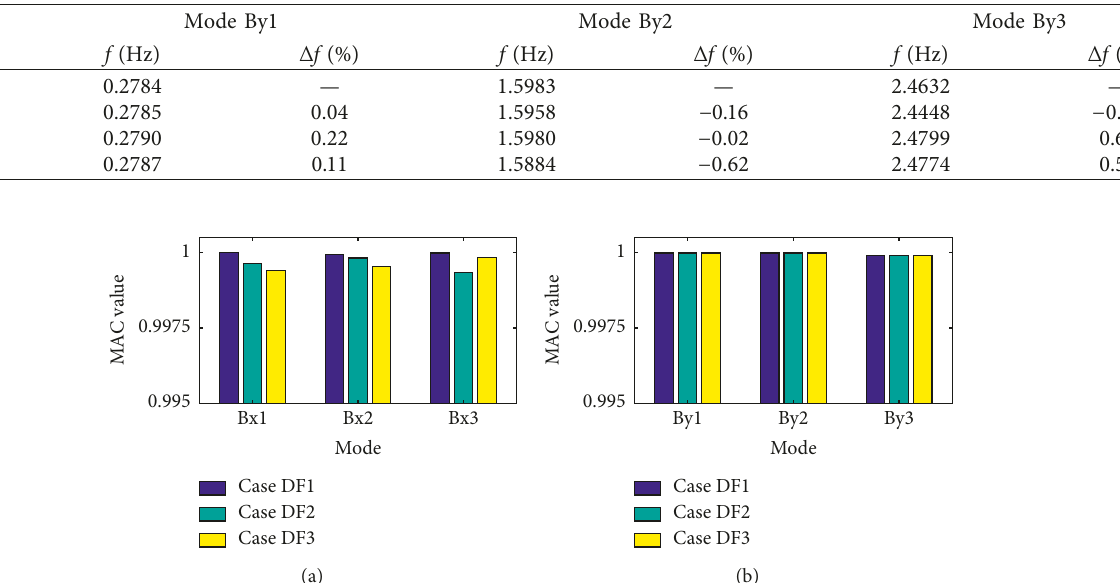
Table 14: Natural frequencies of across-wave bending modes: damage type 3.